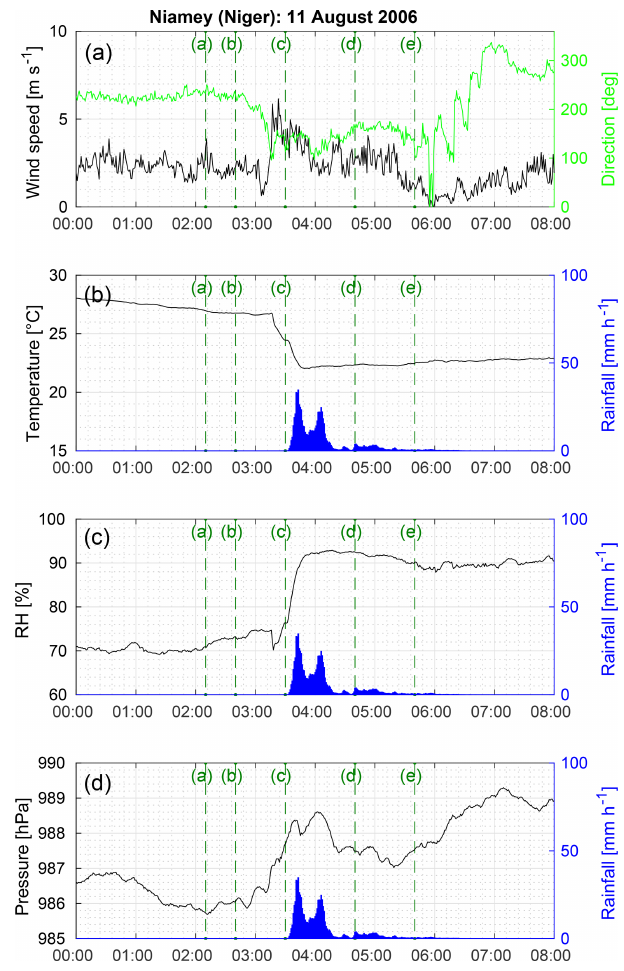
Figure 7. Meteorological data during the MCS event on 11 August 2016 at Niamey (Niger) retrieved from the ARM Mobile Facility at a 1min sampling interval: (a) wind speed (ms − 1 ) and direction ( ◦ ), (b) temperature ( ◦ C), (c) relative humidity (%), and (d) pressure (hPa) are shown using black or green lines, and rainfall (mmh − 1 ) is shown using blue bar plots. The times for the reflectivity maps given in Fig. 6 are shown using vertical dashed green lines and correspond to (a) 02:10UTC, (b) 02:40UTC, (c) 03:30UTC, (d) 04:40UTC, and (e)